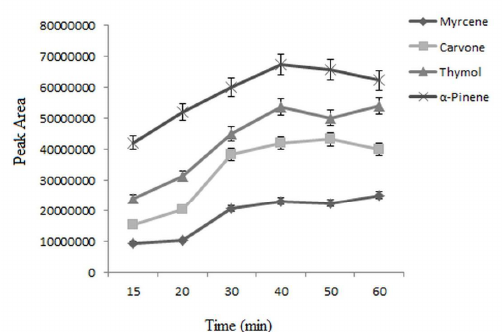
Fig. 1 . Effect of extraction time on extraction efficiency